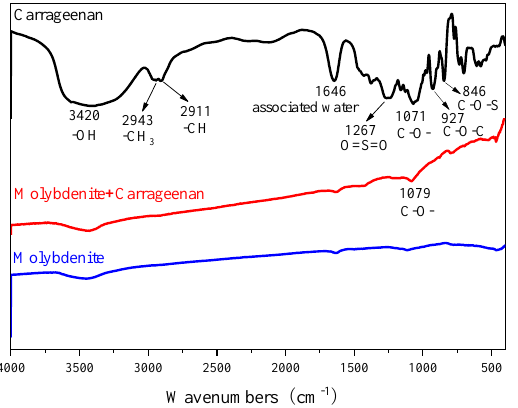
Figure 7. The FTIR spectra of molybdenite before and after treatment.